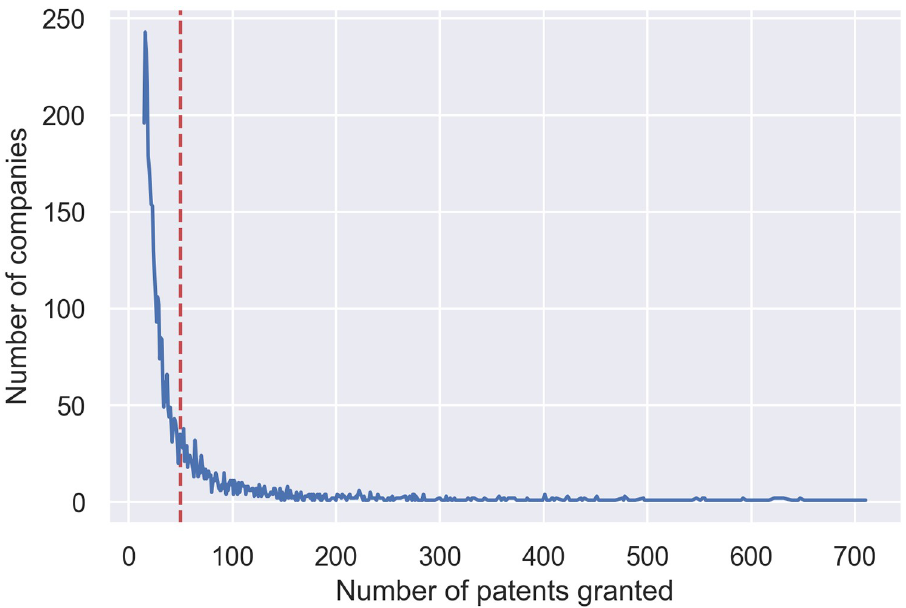
Fig 2. Patent distribution by top-5000 companies (best viewed in color) without top-100 companies. The threshold line for Prolific Applicants is marked with a red dashed line.